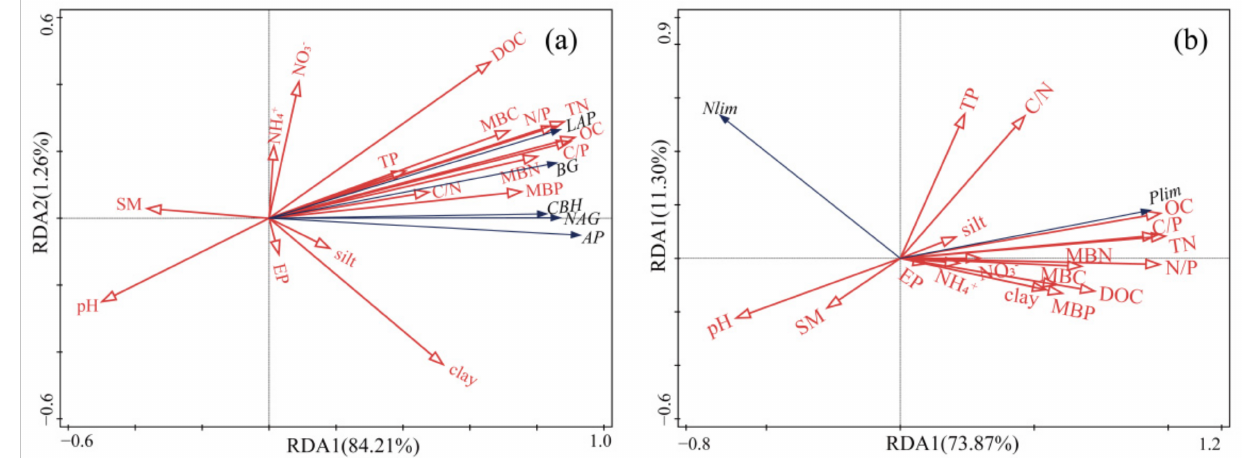
Figure 4. The redundancy analysis (RDA) was used to identify the ( a ) relationship between enzyme activities and soil physicochemical and microbial properties and ( b ) the relationship between micro- bial nutrient limitations and soil physicochemical and microbial properties. SM: soil moisture; OC: soil organic carbon; TN: total nitrogen; TP: total phosphorus; MBC: microbial carbon; MBN: microbial nitrogen; MBP: microbial phosphorus; DOC: dissolved organic carbon; EP: soil available phosphorus; NO 3 − : nitrate nitrogen; NH 4+ : ammonia nitrogen; Nlim: microbial N limitation; Plim: microbial P limitation. Table 1. Simple term effects and forward selection of environmental variables on soil enzyme activities from the redundancy analysis (RDA). Variable Simple Term